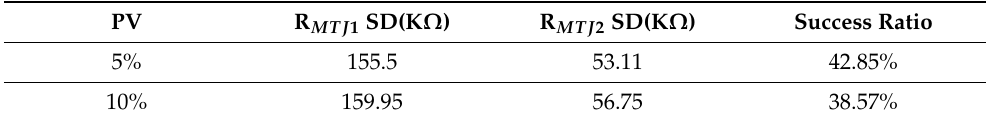
Table 2. 250 Monte Carlo simulation results (LDS method) for